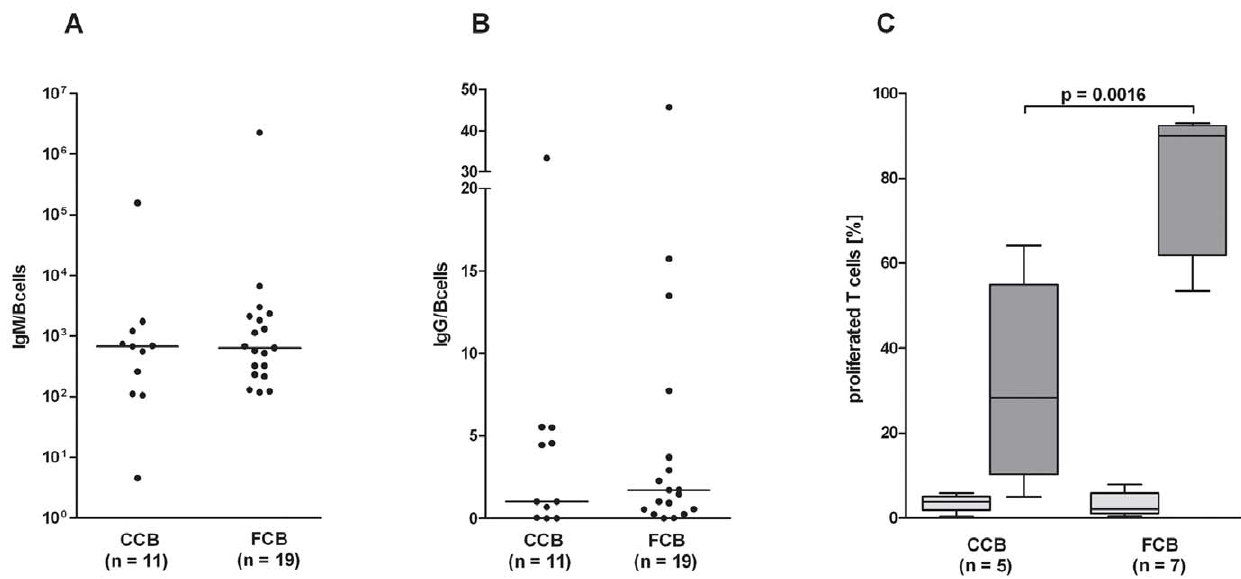
Figure 5. Humanized mice generated functional human B and T cells. (A, B) The concentration of human IgM and IgG in the plasma of humanized mice was determined by cytometric bead array 19–21 weeks after intrahepatic transplantation of CD34 + cells from CCB or FCB. (C) Spleen cells were labeled with CFDA-SE and cultured for 5 d in the presence (dark gray bars) or absence (gray bars) of an anti-CD3 antibody. Proliferation of cells was determined by flow cytometry. Box plots depict median and 5–95% percentile. Level of significance is given.